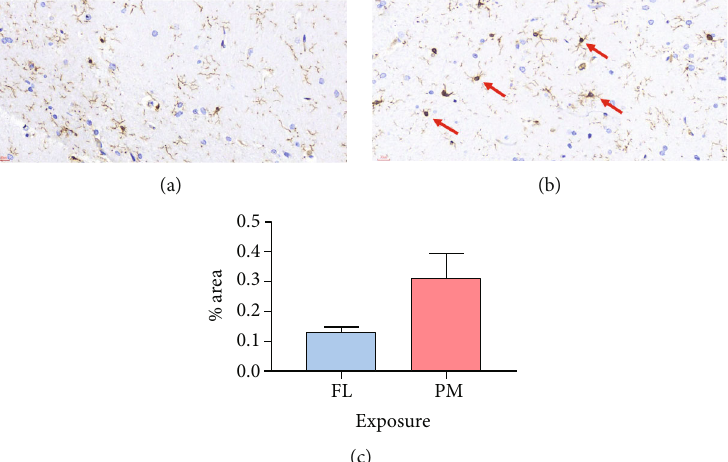
Figure 4: The immunostaining (brown-colored nuclei, red arrows) in the hippocampus of the PM rats (a), FL rats (b), and the di ff erences between these two groups